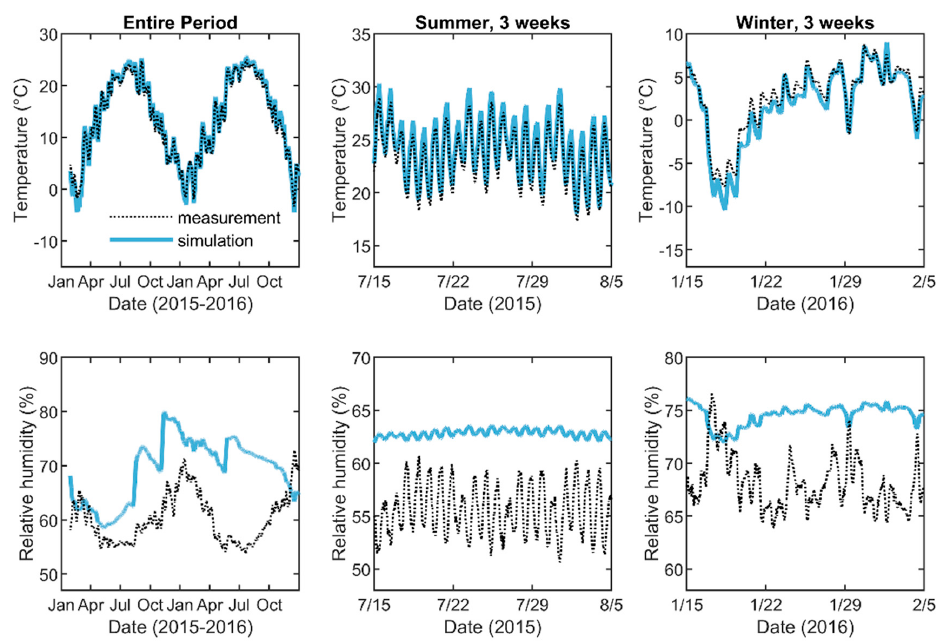
Figure 19. Measured and simulated temperature ( top row ) and relative humidity ( bottom row ) for XPS, poly N wall. Table 4. RMSE for each component of scaled error in south walls; also includes the average Bias in model prediction